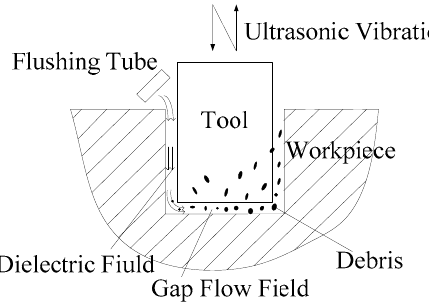
Figure 1. Process of debris motion in small hole machining of ultrasonic assisted electrical discharge machining (EDM).